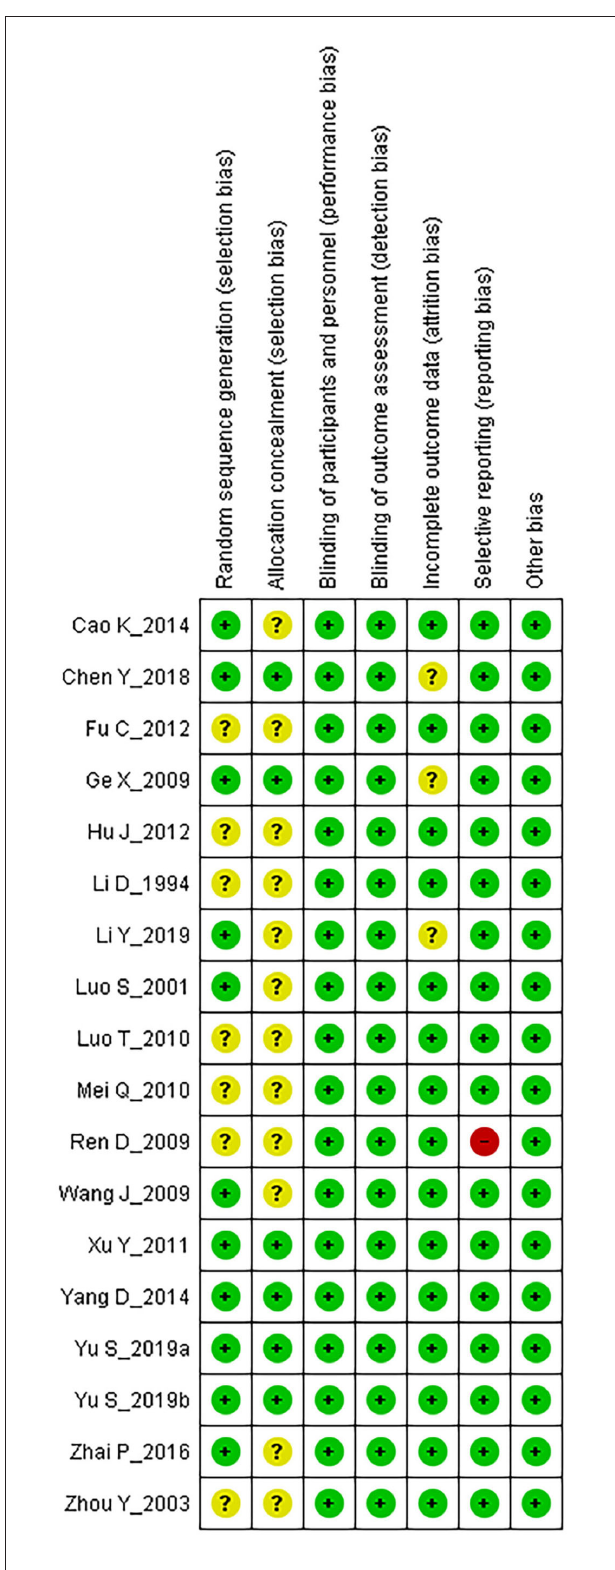
FIGURE 2 | Risk of bias